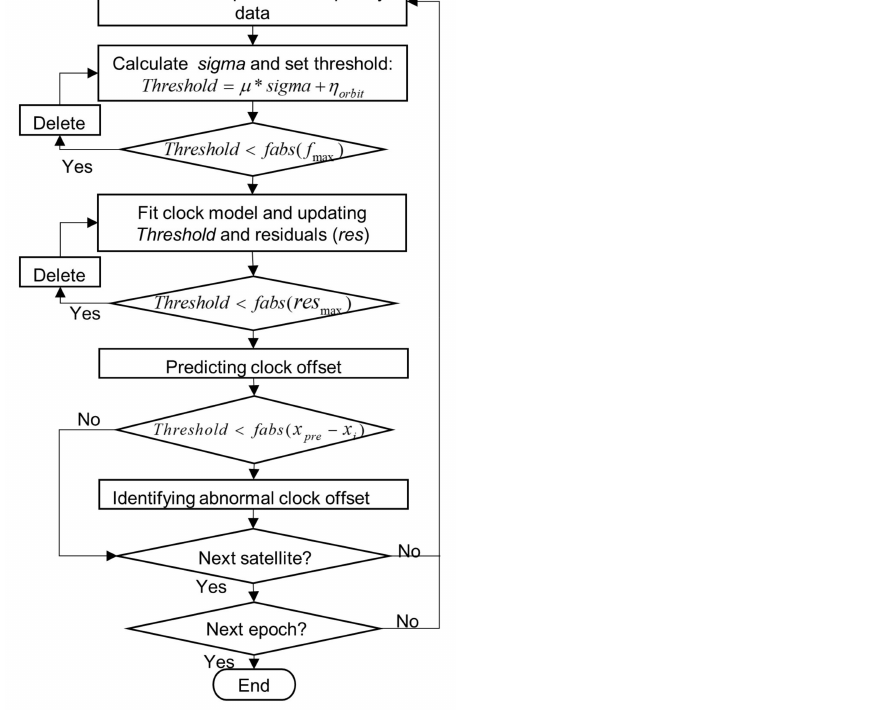
Figure 1. Flowchart of the linear moving short-term clock prediction and detection algorithm at one